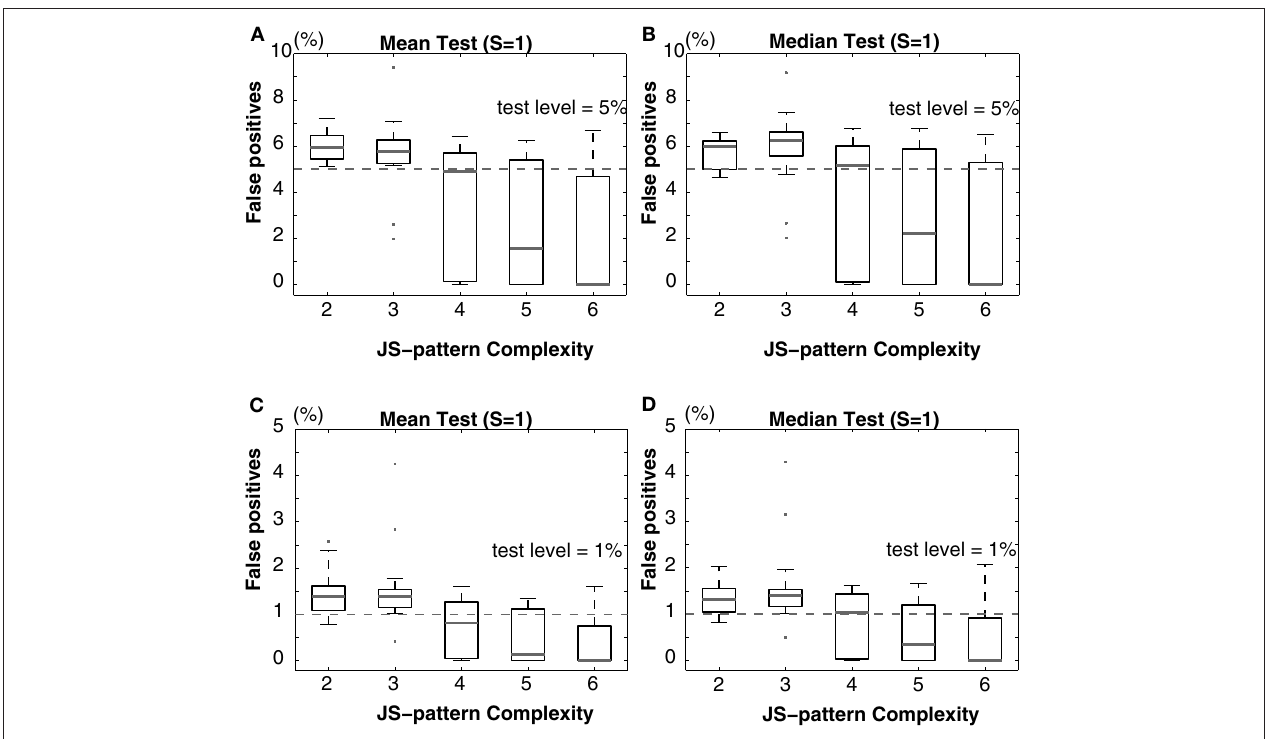
medians. The standard set of parameters is defined by 50 trials ( T ), a mean spike rate of 15 spikes/s ( r ), one surrogate sample ( S ), and h equals 5. From the standard parameter set, eight different combinations of parameters were derived by varying, in turn, the number of trials ( T = 20, 50, 100) and the second through sixth mean spiking rates ( r